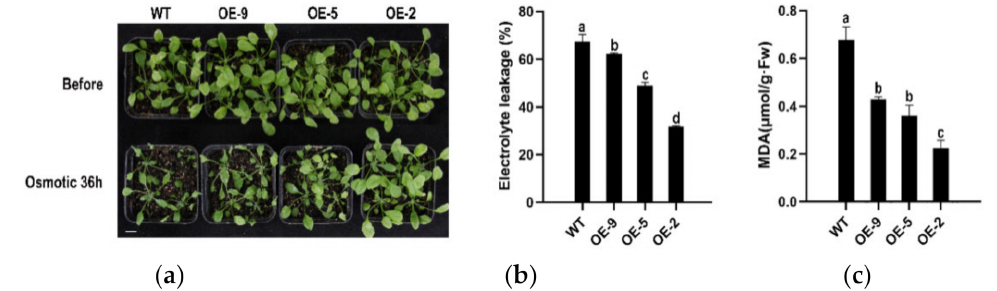
Figure 7. Heterologous expression of CpBBX19 enhanced drought tolerance of transgenic Arabidopsis . ( a ) Performance of Arabidopsis overexpressing CpBBX19 (OE lines) under 30% PEG-6000 treatment. Bar denotes 1 cm. ( b ) Electrolyte leakage of WT and OE lines under 30% PEG-6000 treatment. ( c ) MDA content of WT and OE lines under 30% PEG-6000 treatment. Data represent the mean of three biological repeats ± SD. Error bars indicate standard deviation. Different lowercase letters (a, b, c) on bars indicate significant differences ( p <